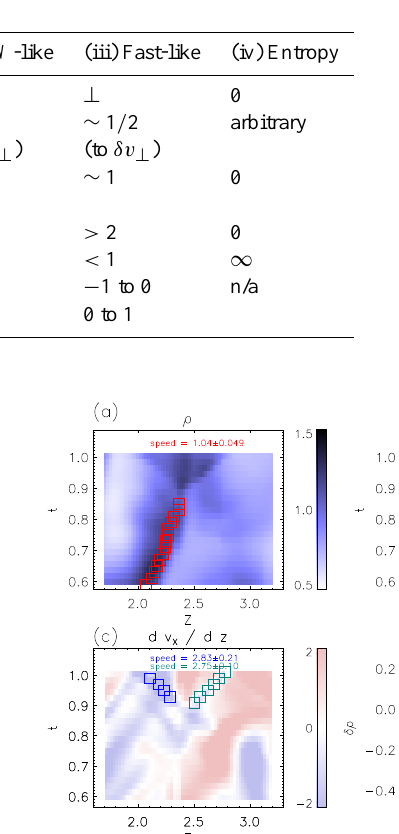
Figure 4. Time profiles of δv (cid:107) (t) and δρ(t) of a composed wave packet containing slow waves with random amplitudes, random wave vectors ( k (cid:107) > 0), and random initial phase. The vertical axis is for oscillating quantities, and the horizontal axis represents time t .